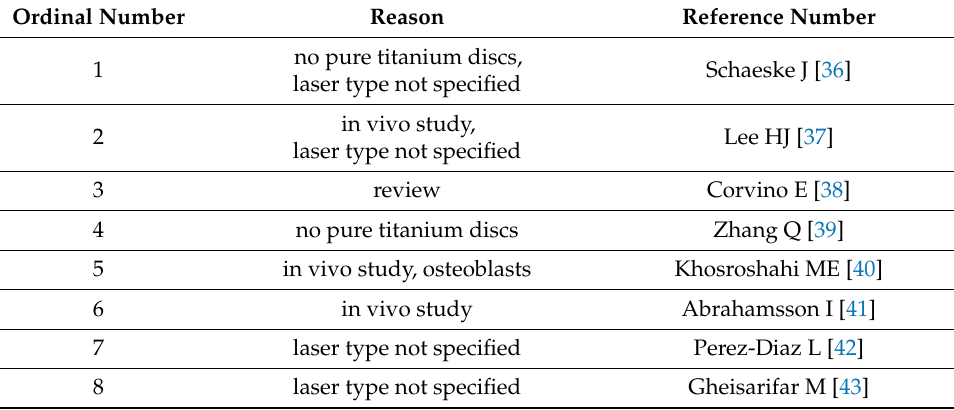
Table 1. Reasons for exclusion of studies.